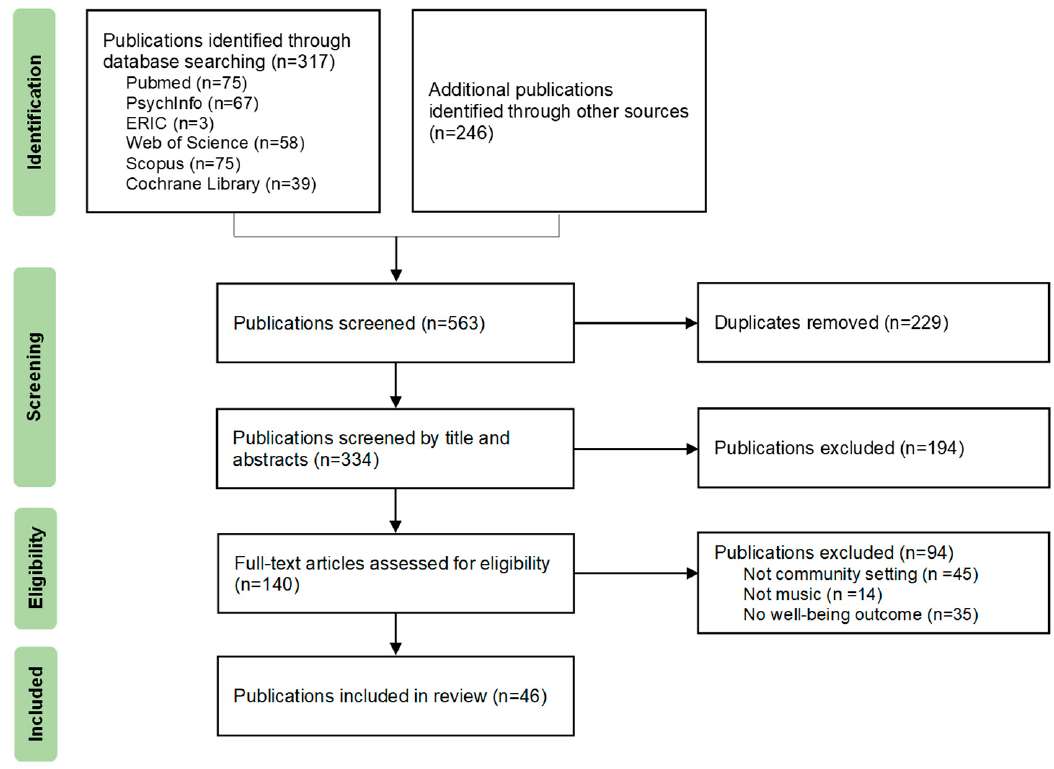
Figure 1. Flow diagram of study selection.